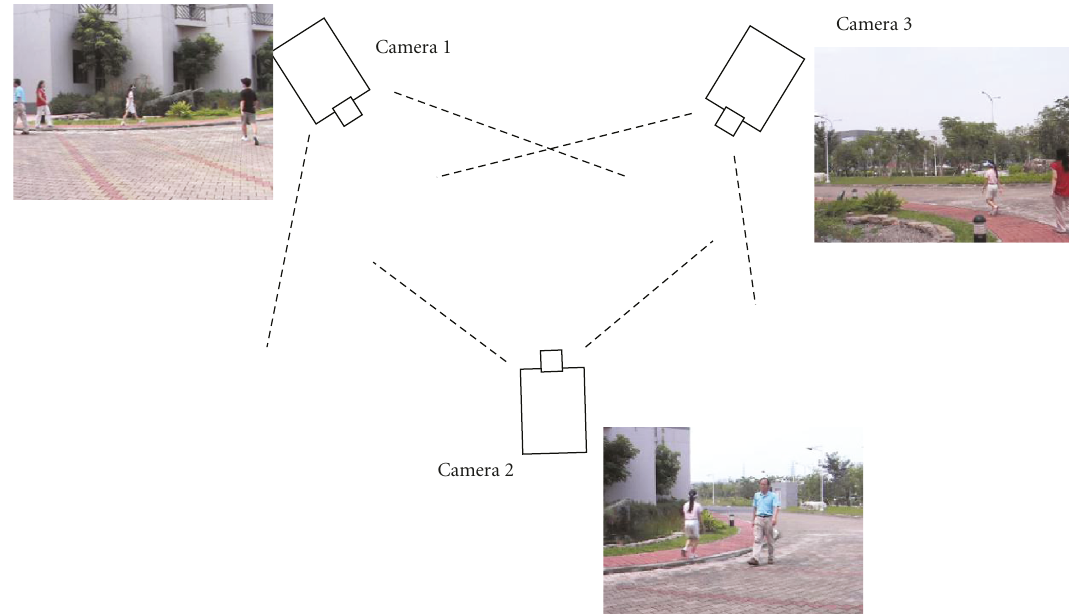
Figure 6: Configuration of the tracking system in the